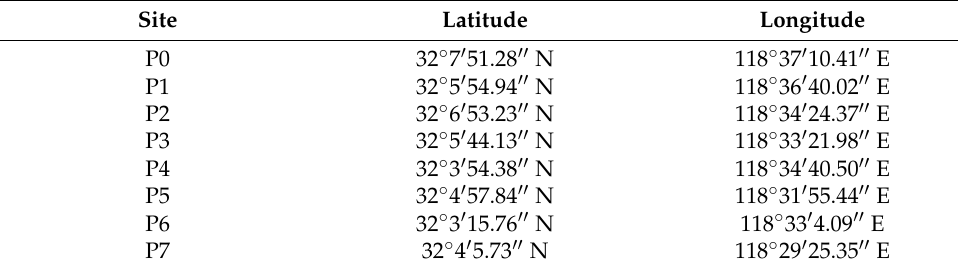
Table 6. Longitude and latitude corresponding to UAV sites.